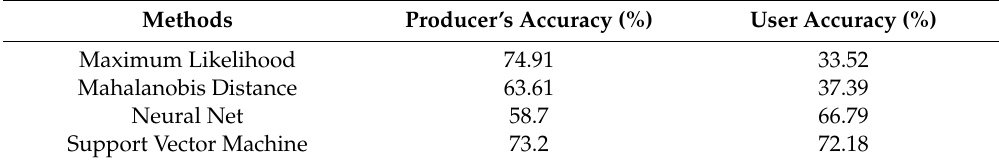
Table 1. Identification accuracy of Ulmus pumila trees using remote sensing image classification